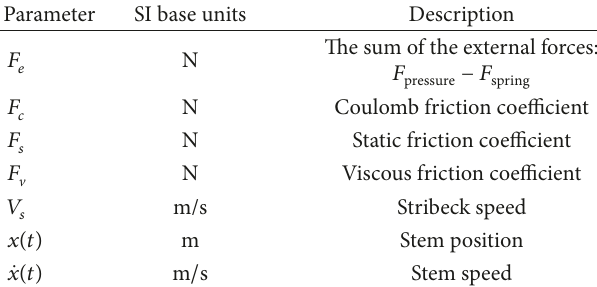
Table 1: Nomenclatures in mathematical Karnopp model.